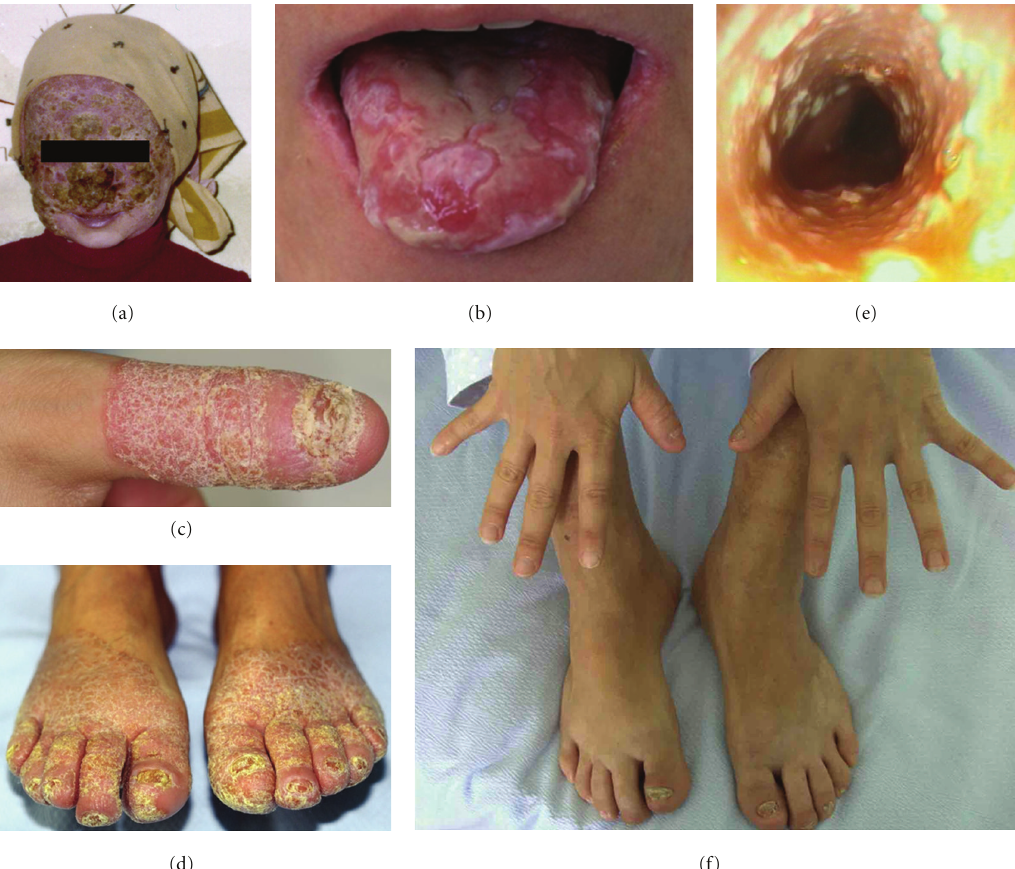
Figure 1: (a) Extensive dermatophytosis, caused by M. canis at 6years of age. (b–e) Clinical presentation of C. albicans infection at the time of admission: (b) whitish and yellowish plaques on the tongue and perleche, secondary to candidal infection; (c) skin and nail of the right thumb, (d) skin and nails of the feet; (e) endoscopy showing severe esophagitis. (f) Hands and feet after 8months of treatment with oral posaconazole, showing a complete regression of skin and nails